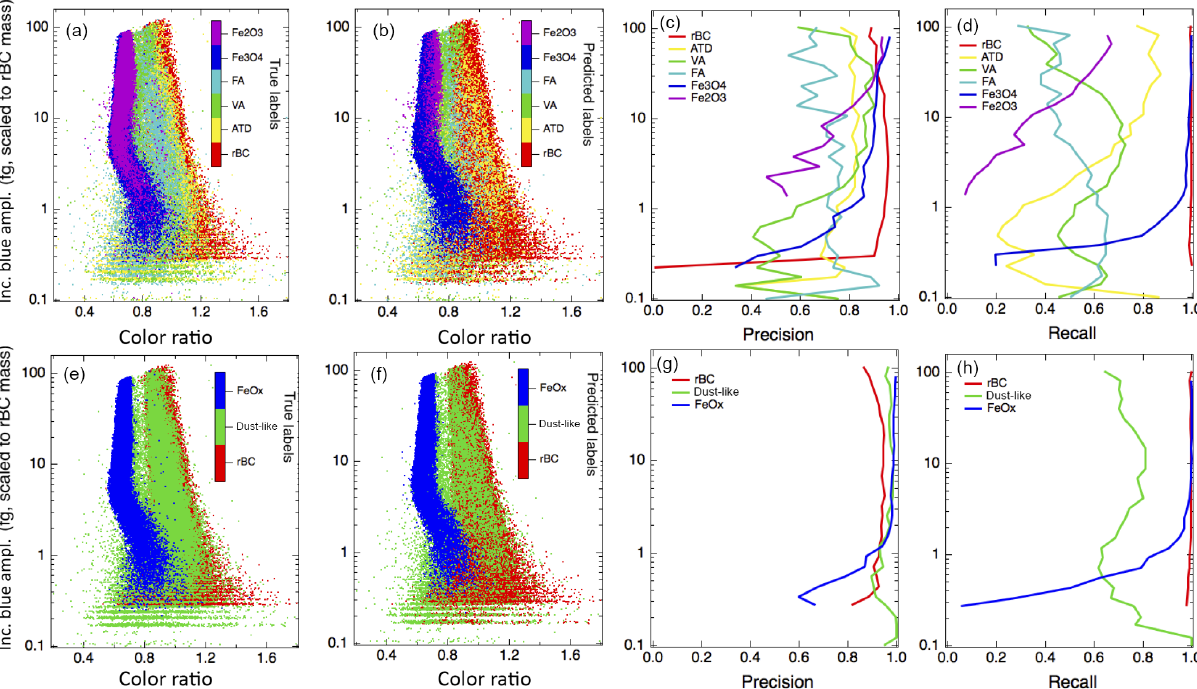
Figure 8. True and predicted labels, precision, and recall by incandescent peak height for the six-class (reduced features) and three-class (reduced features) cases. (a–d) show the performance of the six-class classification scheme and the (e–h) show the performance of the three- class classification scheme. (a) and (e) show the laboratory test data, color coded by its true class label (particles differ between the six-class and three-class cases because different subsets of the laboratory data were randomly chosen as test sets in each case). (b) and (f) show the predictions of the algorithms for the class labels. (c) and (g) show the precision for each class, binned by incandescent peak height. (d) and (h) show the recall, binned by incandescent peak height for each